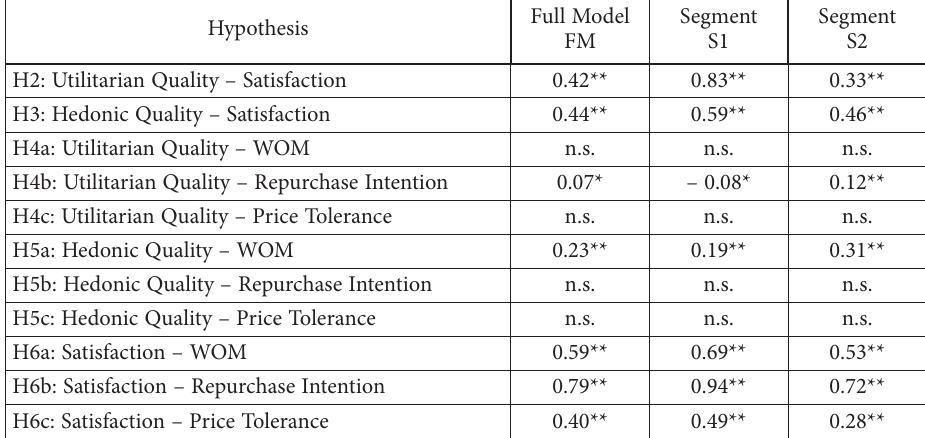
Table 6. Analysis relationship quality-satisfaction-loyalty Hypothesis